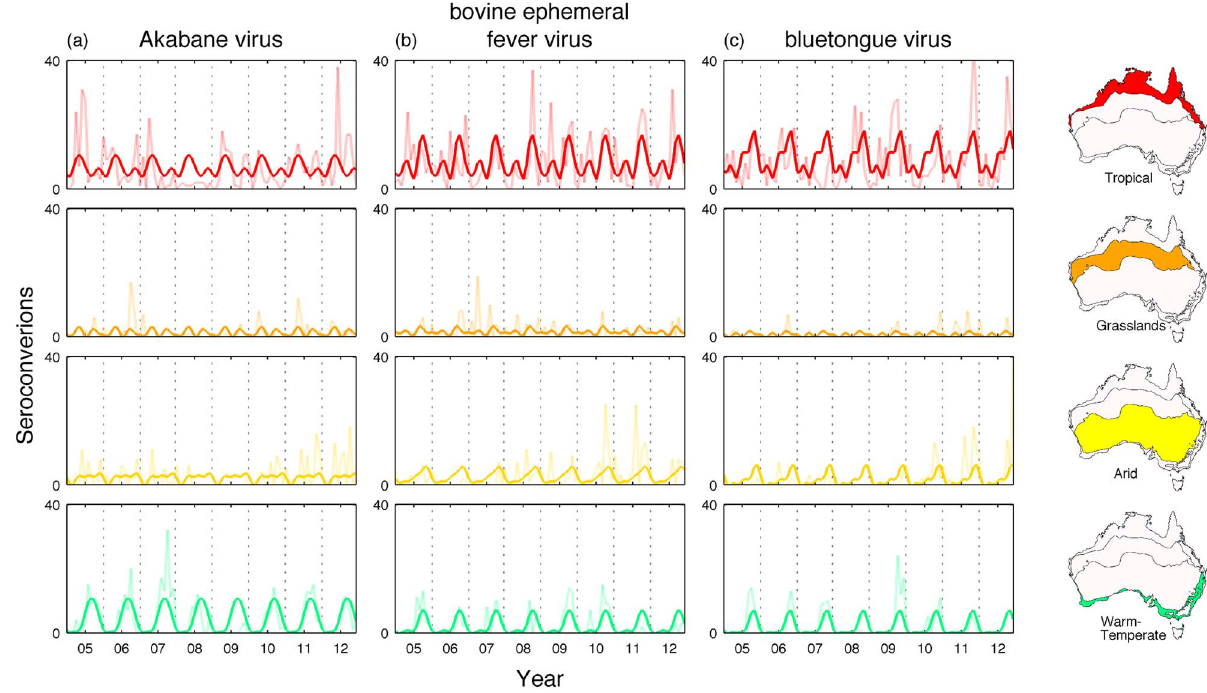
Figure 2. Time series of the number of positive seroconversions per month between July 2004 - June 2012 in four distinct climate regions: tropical, grasslands, arid and warm-temperate for Akabane virus (a), bovine ephemeral fever virus (b), and bluetongue virus (c). The periodic annual function, obtained by summing the 12-monthly, 6-monthly and 3-montly harmonics (bold line) and the raw data (faded line) is shown. Vertical grid lines represent 1 st July for each year, coinciding with the start of the vector season in the southern hemisphere.